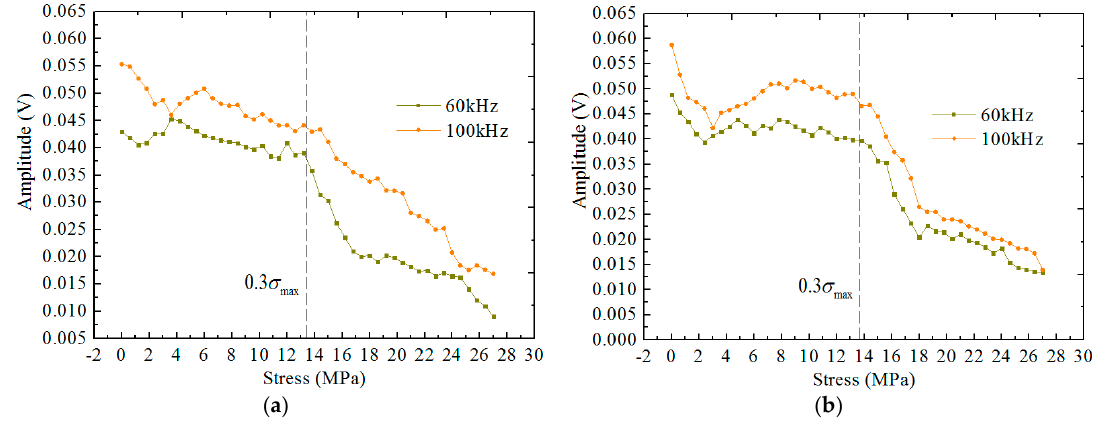
Figure 7. Amplitude development with different stress. ( a ) C1; ( b ) C2.